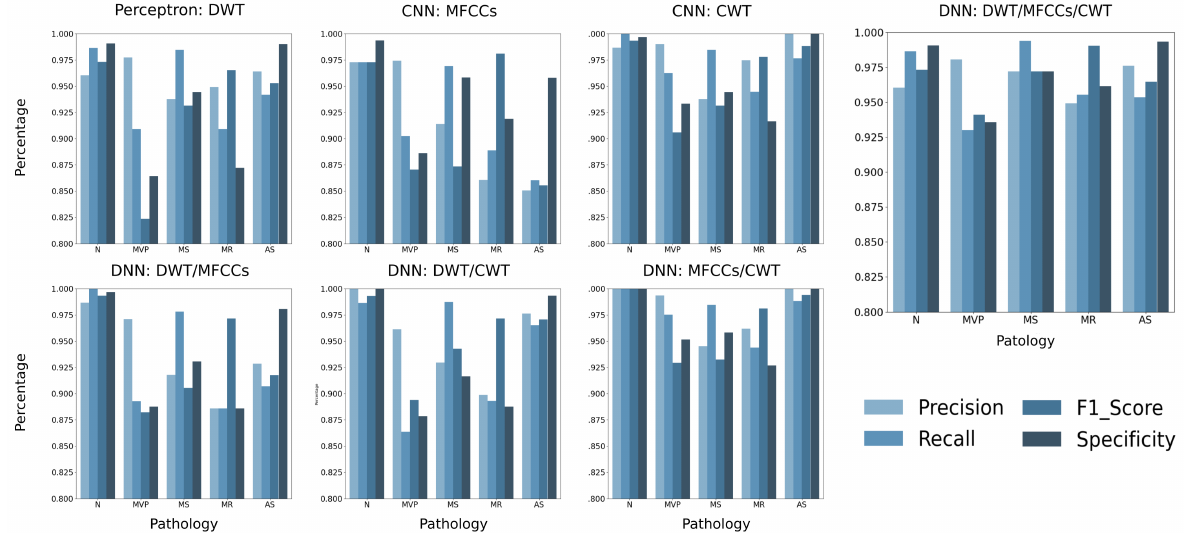
Figure 11. Experimental results: The bar graphs show the results achieved by each architecture, for each class, measured using precision, recall, F1 score and specificity as